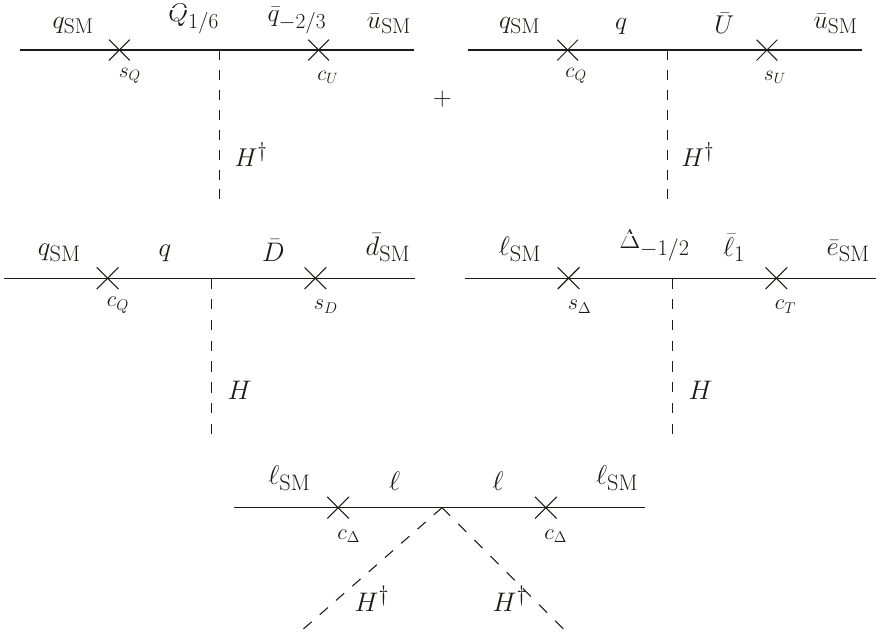
Figure 5 . The generation of SM fermion masses. The mixing angles are de(cid:12)ned so that they vanish in the limit m X